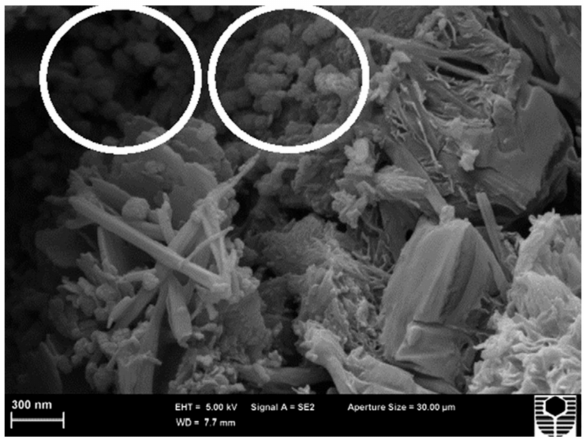
Figure 17. SEM image of 2% nano-Al 2 O 3 by weight of cement paste hydrated up to 7 days. Reprinted with permission from [107]. Copyright © 2014, Elsevier Ltd.